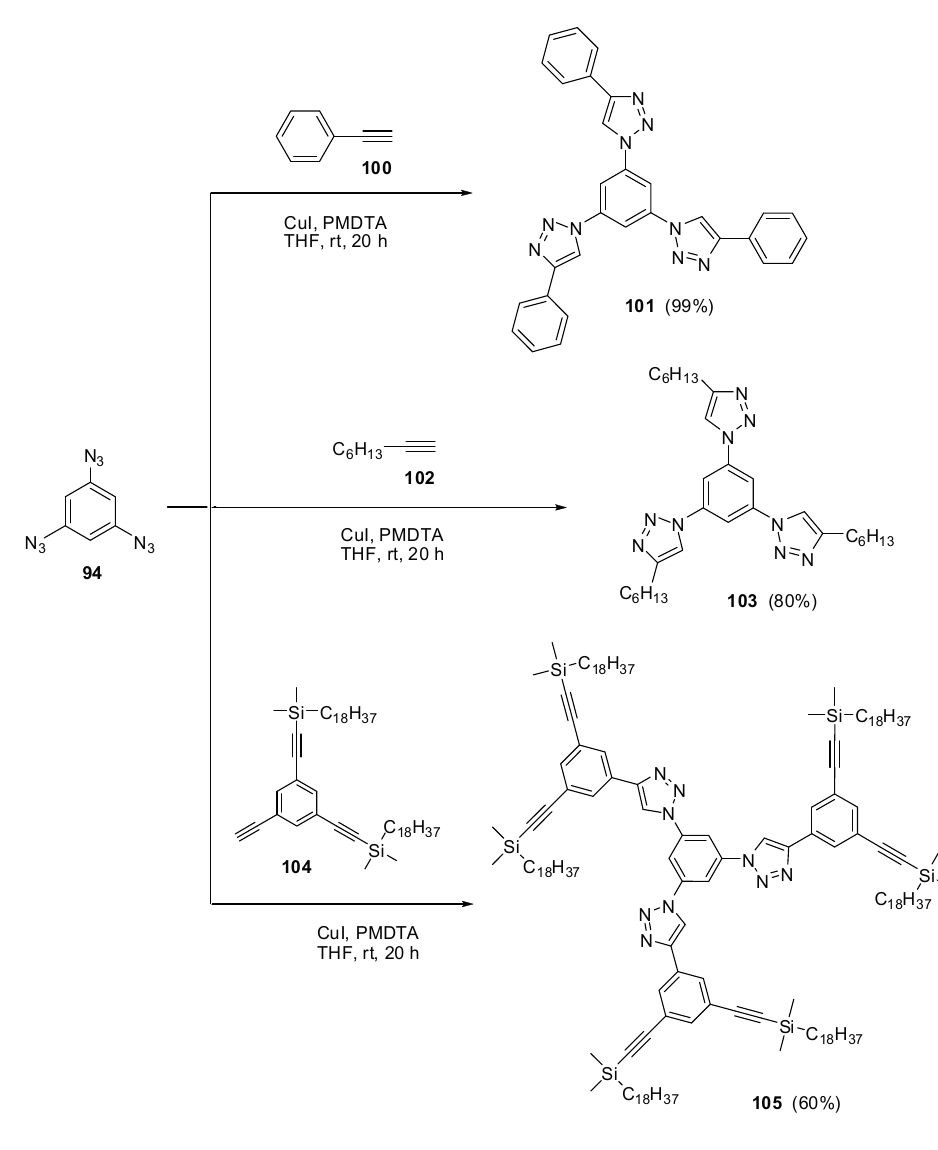
Scheme 26. Some click-reactions of triazide 94 .